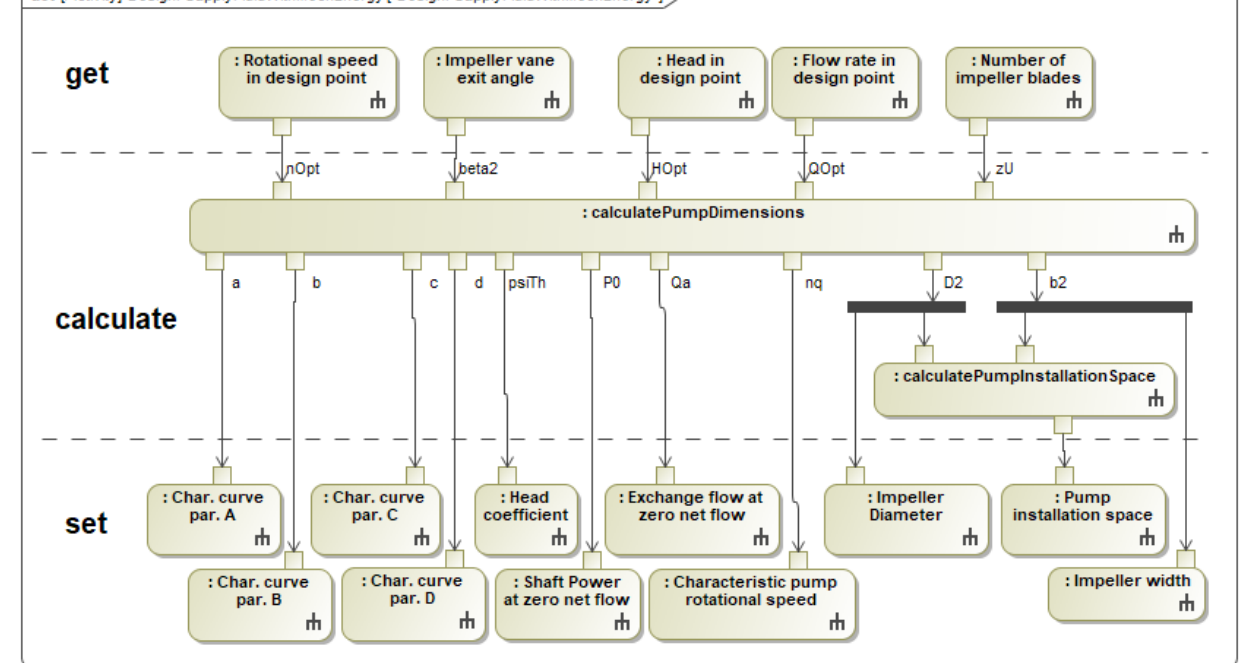
Figure 5. Design workflow for the design of a pump impeller.